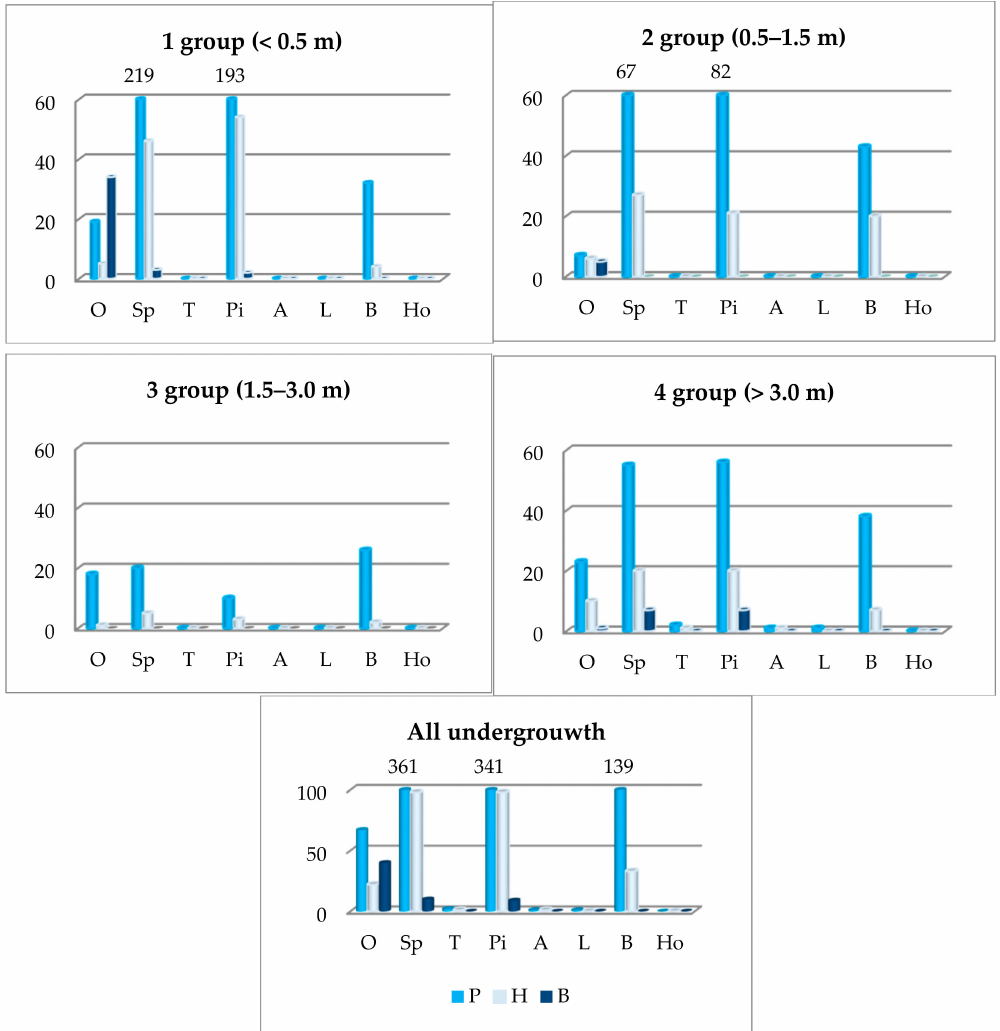
Figure 5. The abundance of oak undergrowth depending on the first storey prevailing species: P—pedunculate oak, H—hybrid oak, S—sessile oak. In the x array: O—oak sp., Sp—Norway spruce, T—the total oak undergrowth, Pi—silver pine, A—black alder, L—small-lived lime, B—common birch, Ho—common